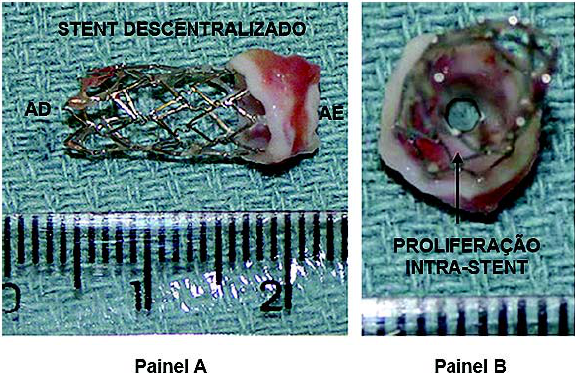
Fig.7 - Stent pré-montado Genesis (6 X 19 mm) mostrando proliferação intra-stent importante, com orifício residual de 3